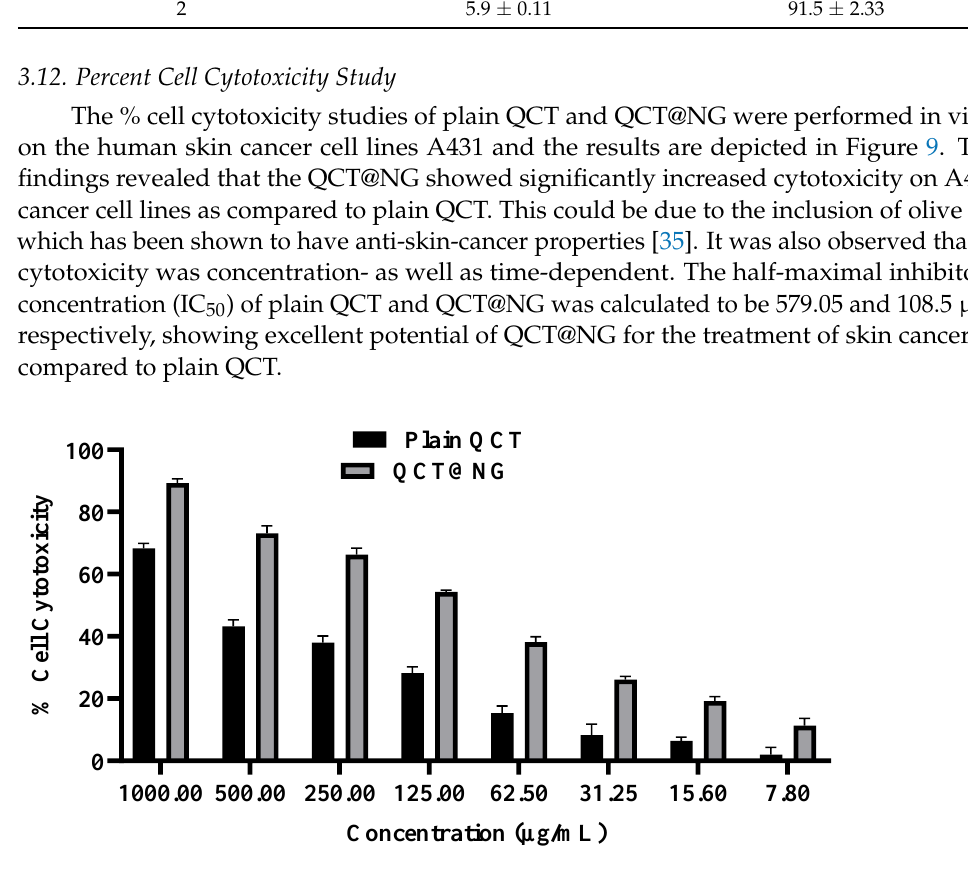
Table 1. Stability data of the optimized QCT@NG (mean ± S.D.).